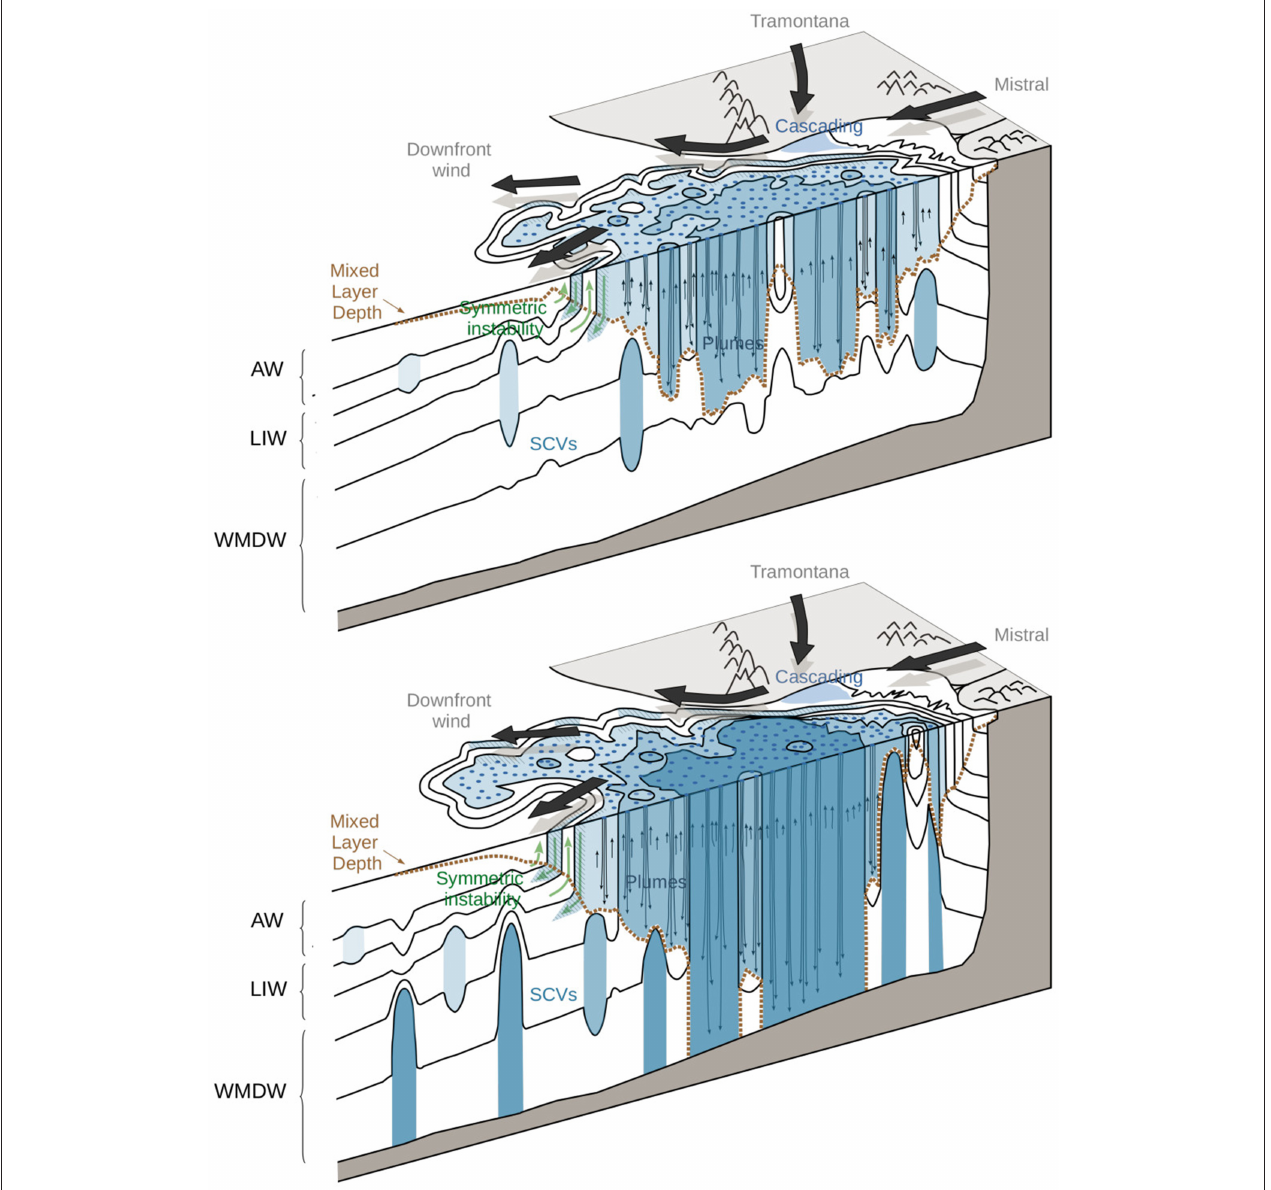
FIGURE 10 | Schematic diagram of the evolution of the convection area during the violent mixing phase in a period of 1–2 weeks. Underlying stratification/outcrop is shown by selected isopycnals (continuous black lines). The volume of fluid just mixed by convection is shaded and color coded according to potential density classes. (Figure 13 from Testor et al., 2018). Numerous glider deployments have allowed to objectively map the (physical and biogeochemical) evolution of the deep convection area on a 10-days basis for quantitative estimates while high resolution measurements allowed to investigate the small scale processes at